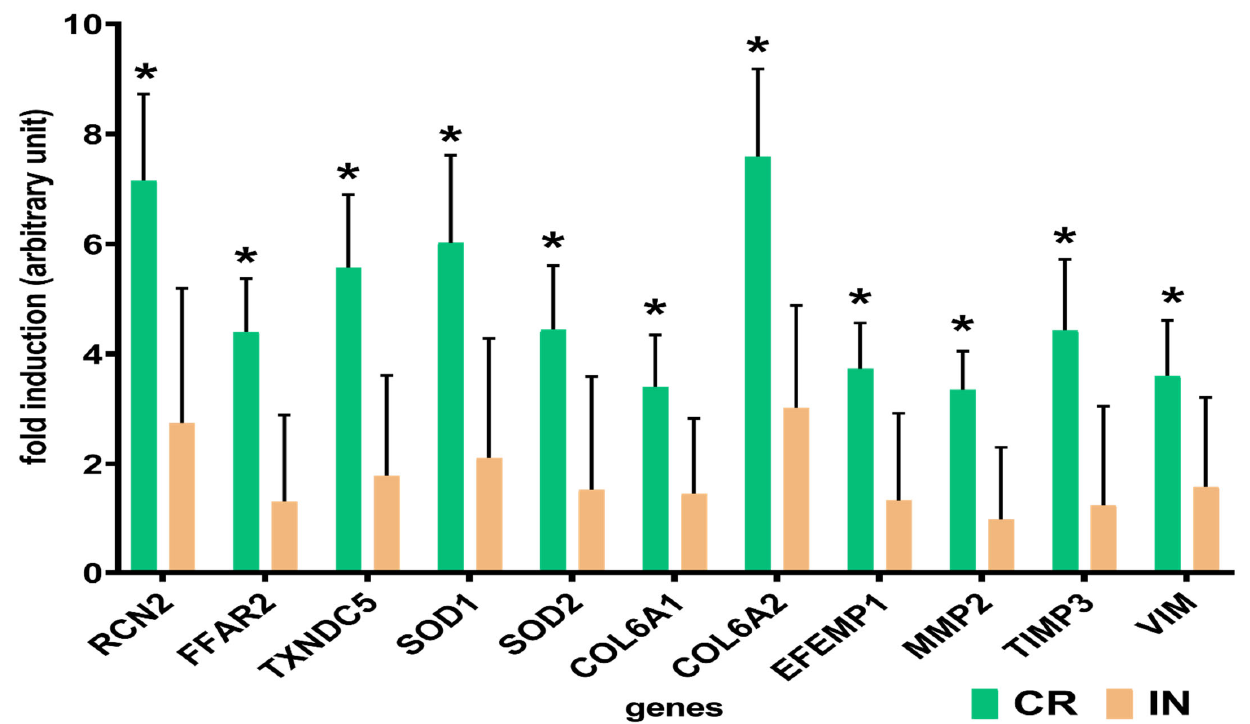
Figure 3. Differences in the relative accumulation of stress response, cytoskeletal and extracellular matrix ‐ related genes in the aorta of pigs fed a diets enriched with 4% of dried chicory root (CR) or 2% of native chicory inulin (IN). Student’s t ‐ test was carried out to determine the considerable differences between experimental and control groups. Values that differed significantly ( p < 0.05) from that of the control group were marked with an asterisk. Fold induction indicates the average ratio of accumulation for genes found in the aorta of pigs fed a diet supplemented with 4% dried chicory root (CR) compared with the control (C) group and 2% of native inulin (IN) compared with the C group. Spot number corresponds to these in Figure 1. Protein and gene names show the unique identifier assigned by the UniProt/NCBI databases. This table also includes: aver ‐ age protein fold change, theoretical and experimental (estimated) isoelectric point (pI) and